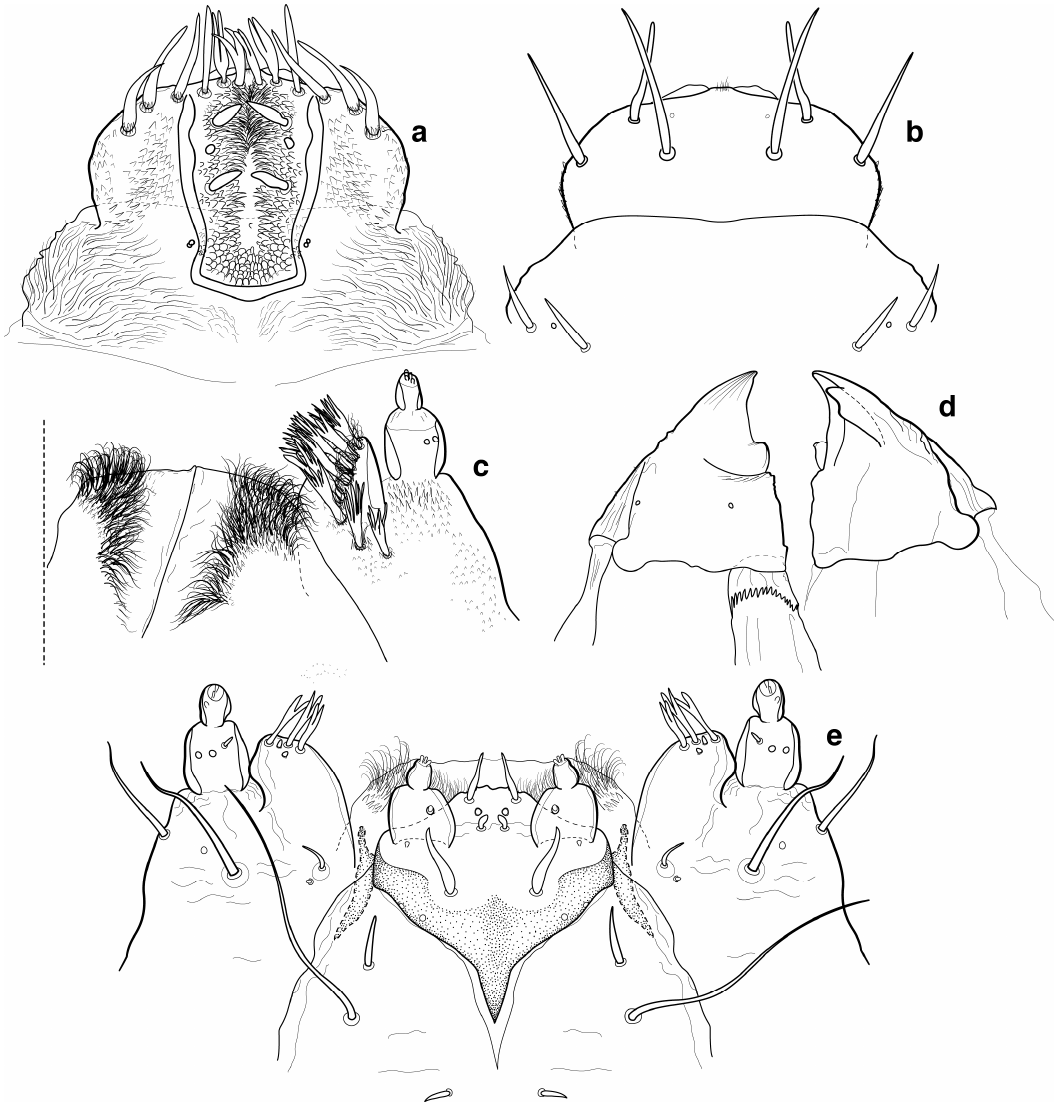
Figure 69. Nassophasis sp. Mouthparts: ( a ) epipharynx; ( b ) clypeus and labrum; ( c ) maxillae and hypopharynx, dorsal view; ( d ) spiracles; ( e ) mandibles; and ( f ) labio-maxillary complex, ventral view.